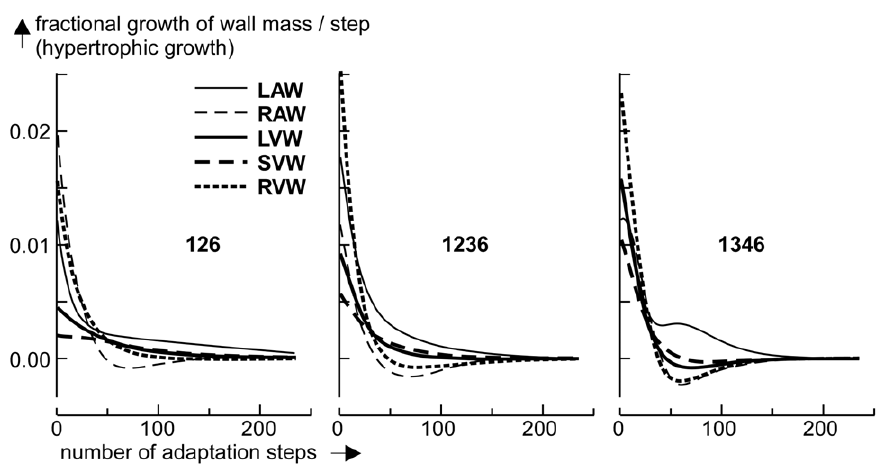
Figure 7. Simulation of hypertrophic growth of the five myocardial walls. The fractional change of wall mass per adaptation step is plotted as a function of the number of steps after 20% increase of cardiac output. The numbers 126, 1346 and 1236 refer to the applied combination of sensed variables, used for mechano-feedback (Table 3). After fast mass growth during the first 25 cycles, for combination 126 a slow component remains active for a long time. Convergence with 1236 is best. Convergence with 1346 is also fast, but there is more overshoot.